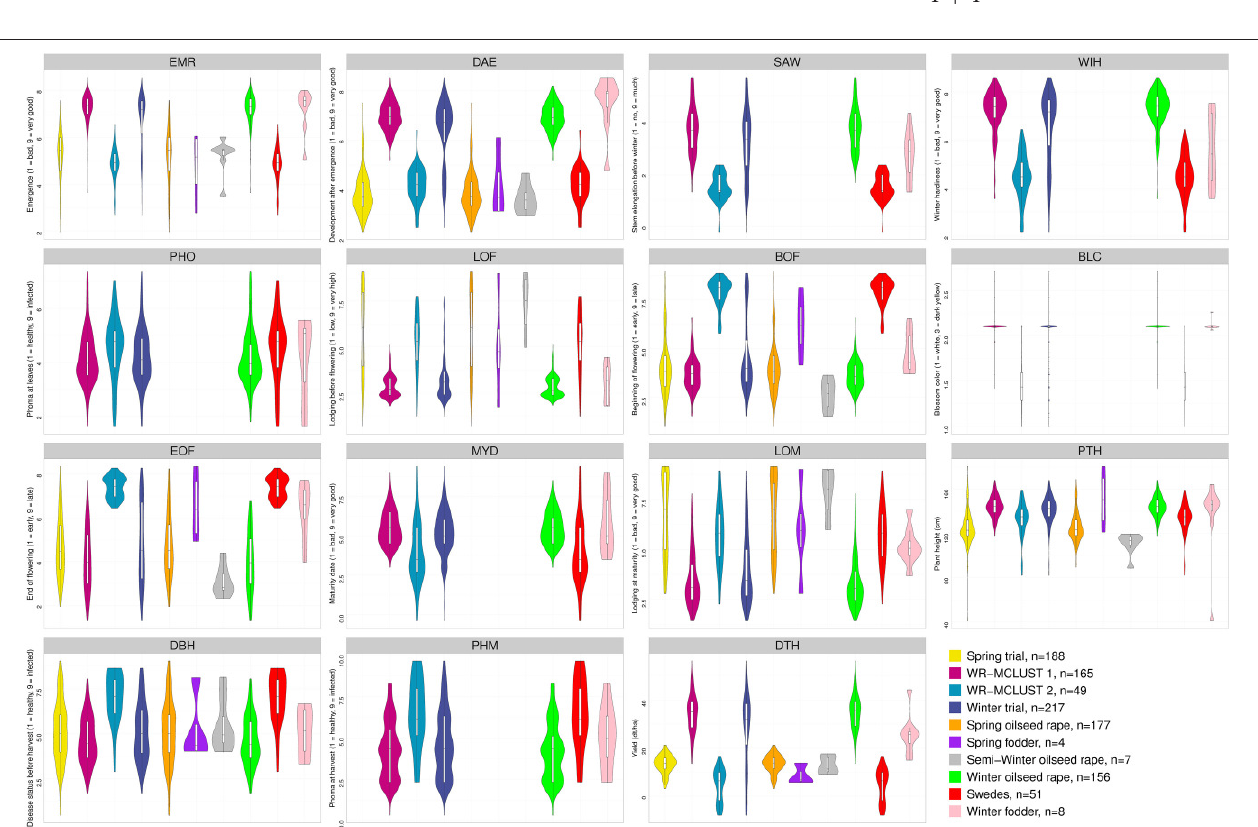
FIGURE 1 | Frequency distribution of adjusted entry means determined for 15 agronomic traits of the B. napus inbred lines for the spring and winter trial as well as the two WR-MCLUST groups and for six different germplasm types represented by different colors. Yellow plots represent the 188 inbreds of the spring trial and blue plots the 217 inbreds of the winter trial. The number of genotypes for each germplasm type is given in the legend. In each plot, a marker denotes the median of the data, a box indicates the interquartile range, and spikes extend to the upper and lower adjacent values, overlaid is the density.